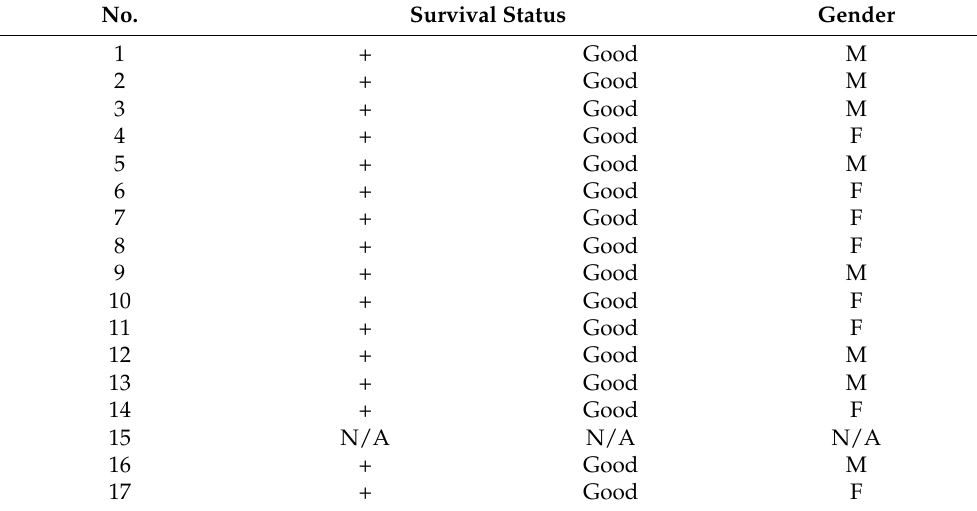
Table 2. Survival and gender records for 14 days incubating of fetal Kinmen county chicken. No. Survival Status